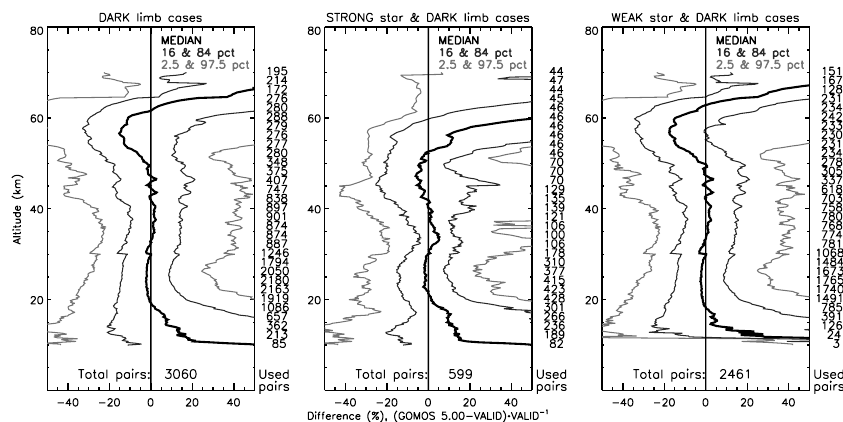
Fig. 5. As Fig. 4, but showing validation results for different star magnitude ranges. Left panel: all cases together; middle panel: observations using strong stars; right panel: observations using weak stars.